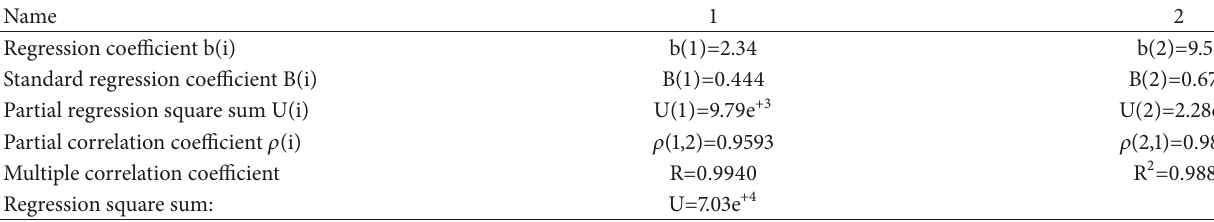
Table 4: Regression analysis coefficient.